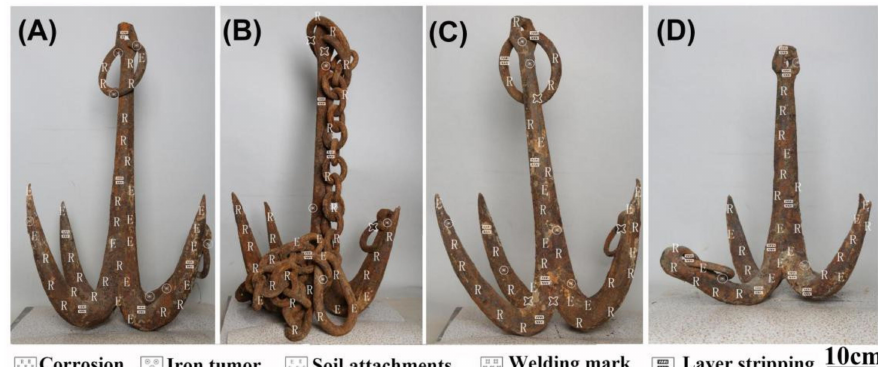
Figure 3. Typical diseases of the anchors: ( A – D ) are disease maps of four samples.